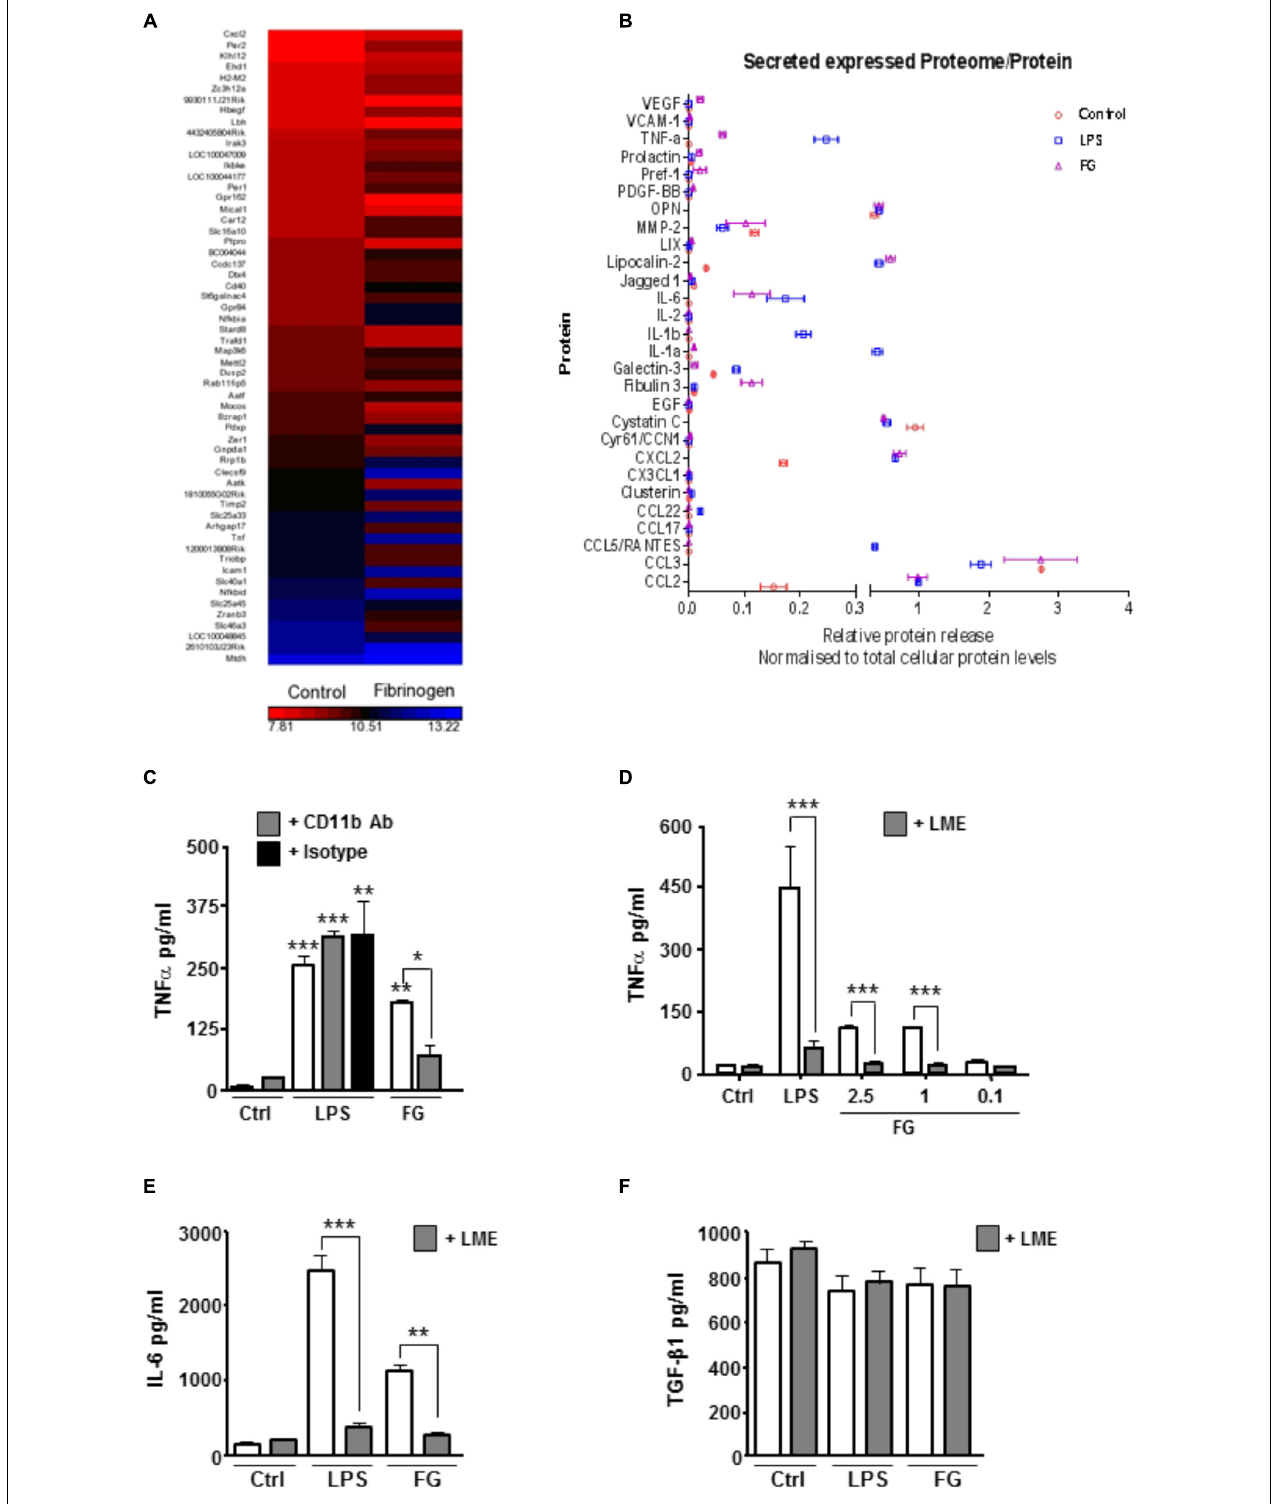
FIGURE 1 | FG induces early upregulation of inflammatory related genes and release of inflammatory cytokines. (A) Gene microarray performed on the BV2 microglial cell line after Fibrinogen (2.5 mg/ml) exposure for 6 h compared with non-stimulated (Control) BV2 cells at 6 h. (B) Proteome array performed on primary microglia following 24 h of stimulation with lipopolysaccharide (LPS, 1 µ g/ml), Fibrinogen (FG, 2.5 mg/ml) or non-stimulated cells (Control). (C) TNF α secretion in cell